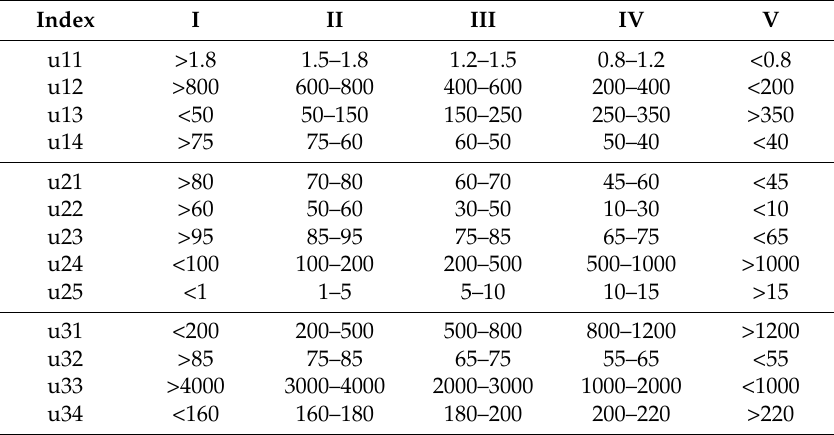
Table 3. Index assessment